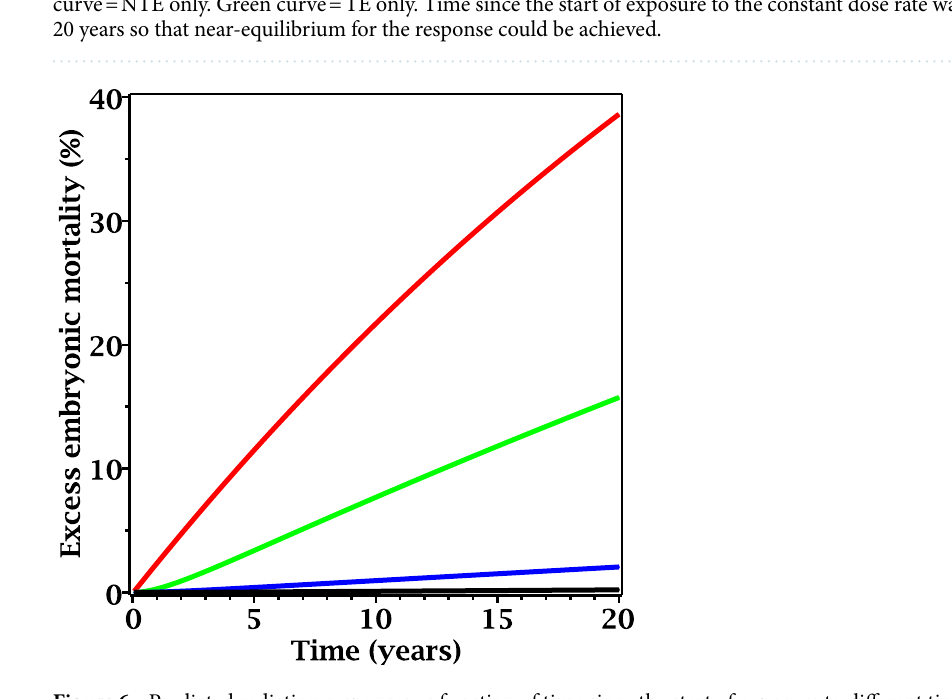
Figure 6. Predicted radiation responses as function of time since the start of exposure to different time- dependent dose rates based on best-fit model parameters for rodent ( Clethrionomys glareolus ) data. In all curves, the time needed for dose rate to decrease by twofold is 1 year. Red curve: initial dose rate = 100 µGy/h. Green curve: initial dose rate = 1 µGy/h. Blue curve: initial dose rate = 0.1 µGy/h. Black curve: initial dose rate = 0.01